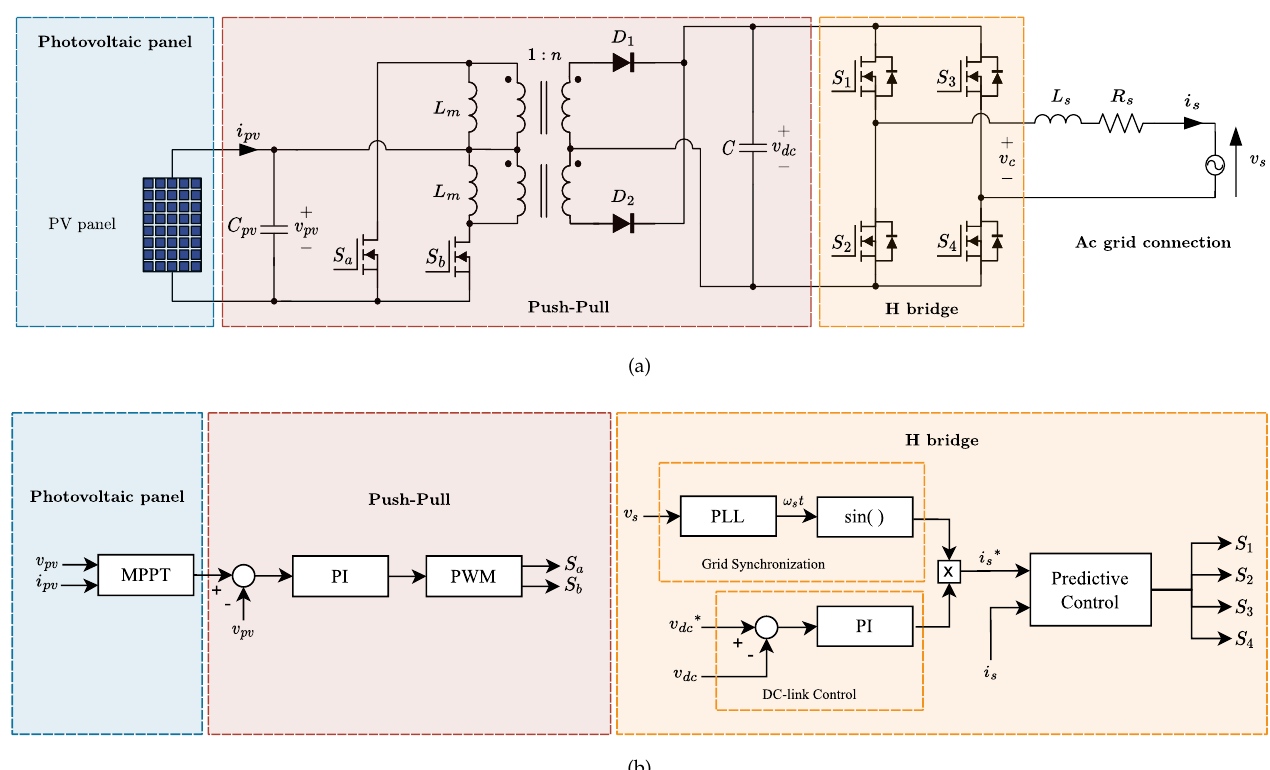
Figure 1. ( a ) Push–pull microinverter, ( b ) control applied in the